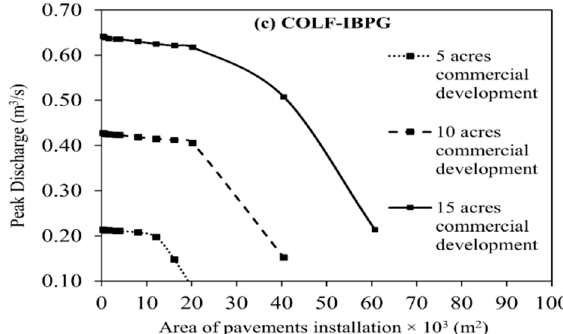
Figure 6. Plot demonstrating peak discharge behavior from a 50-year 24-h rainfall event as a function of the size of commercial development and pavement installation areas. ( a ) City of Brownsville (COB)-Porous Concrete Pavement (PCP), ( b ) Cameron County Drainage District#1 (CCDD#1)-Permeable Interlocking Concrete Pavement (PICP), and ( c ) City of La Feria (COLF)-Interlocking Block Pavement with Gravel (IBPG). Table 5. Assessment of PCP installation size requirements to meet a 10-year storm event discharge goal for 5, 10, and 15 acres of commercial development.